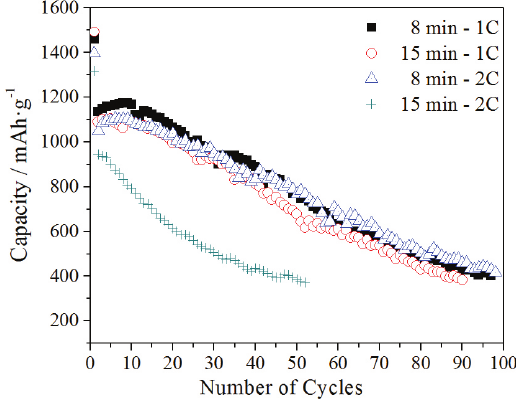
O nanoparticles at 1C rate. 3 4